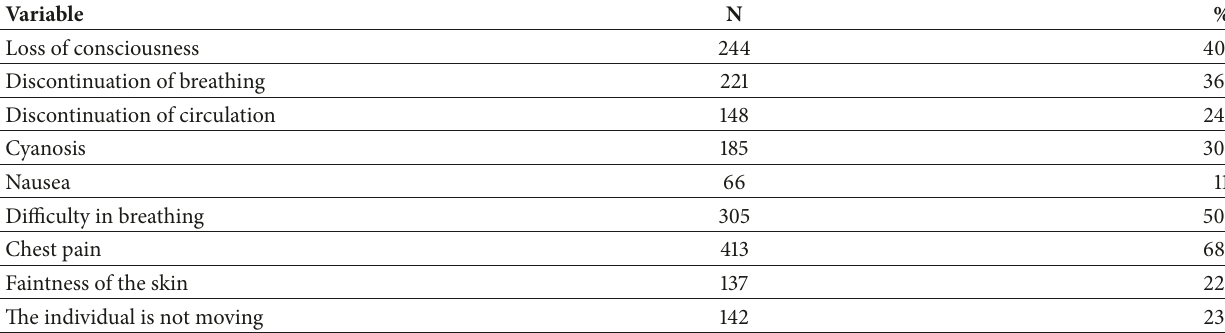
Table 2: Prodromal symptoms and signs of sudden cardiac